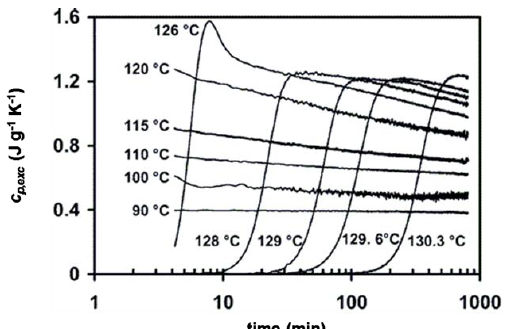
Figure 12. Evolution of the excess specific heat capacity ( c p,exc ) with time during quasi-isothermal crystallization of a linear PE at the indicated temperatures ( A T = 0.8 K and p = 48 s). (Reprinted (adapted) with permission from [60]. Copyright (2004) American Chemical Society).